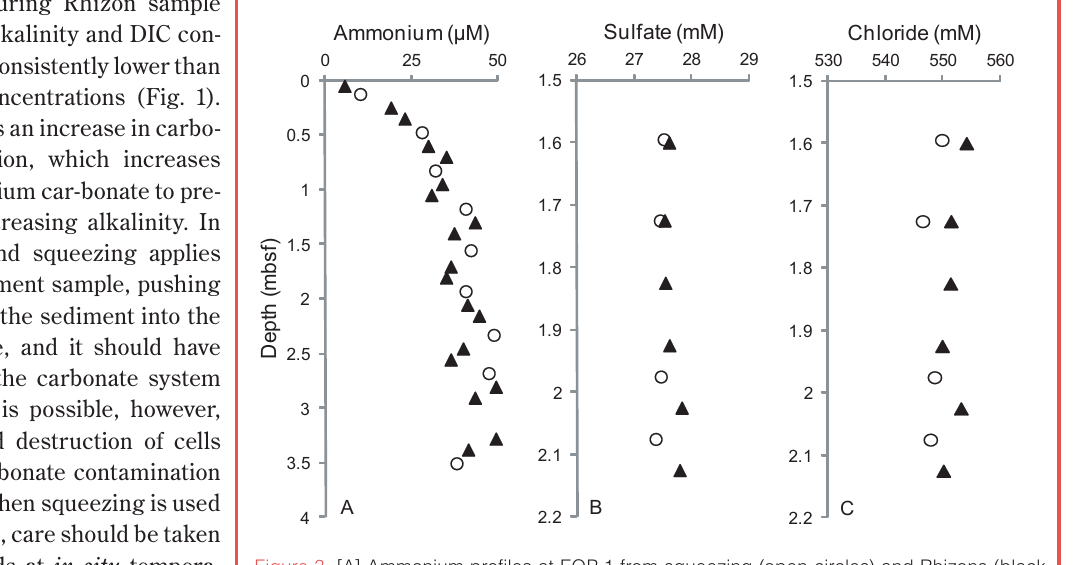
Figure 3. [A] Ammonium profiles at EQP-1 from squeezing (open circles) and Rhizons (black triangles). [B] Sulfate profiles at EQP-6 from squeezing (open circles) and at EQP-6A from Rhizons (black triangles). [C] Chloride profiles at EQP-6 from squeezing (open circles) and at EQP-6A from Rhizons (black triangles). EQP-6 and EQP-6A are nearly at the same location. Note differences in scales between sites. 3%, 0.15%, and 0.2% error bars on ammonium, sulfate and chloride profiles, respectively, are smaller than